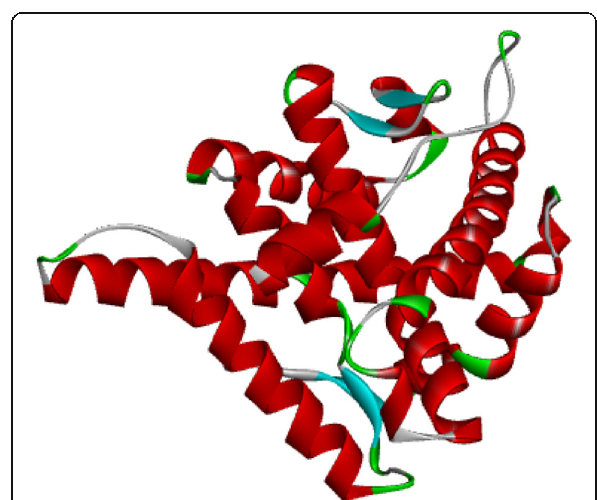
Plate 1 Crystal structure of prepared androgen receptor (PDB ID: